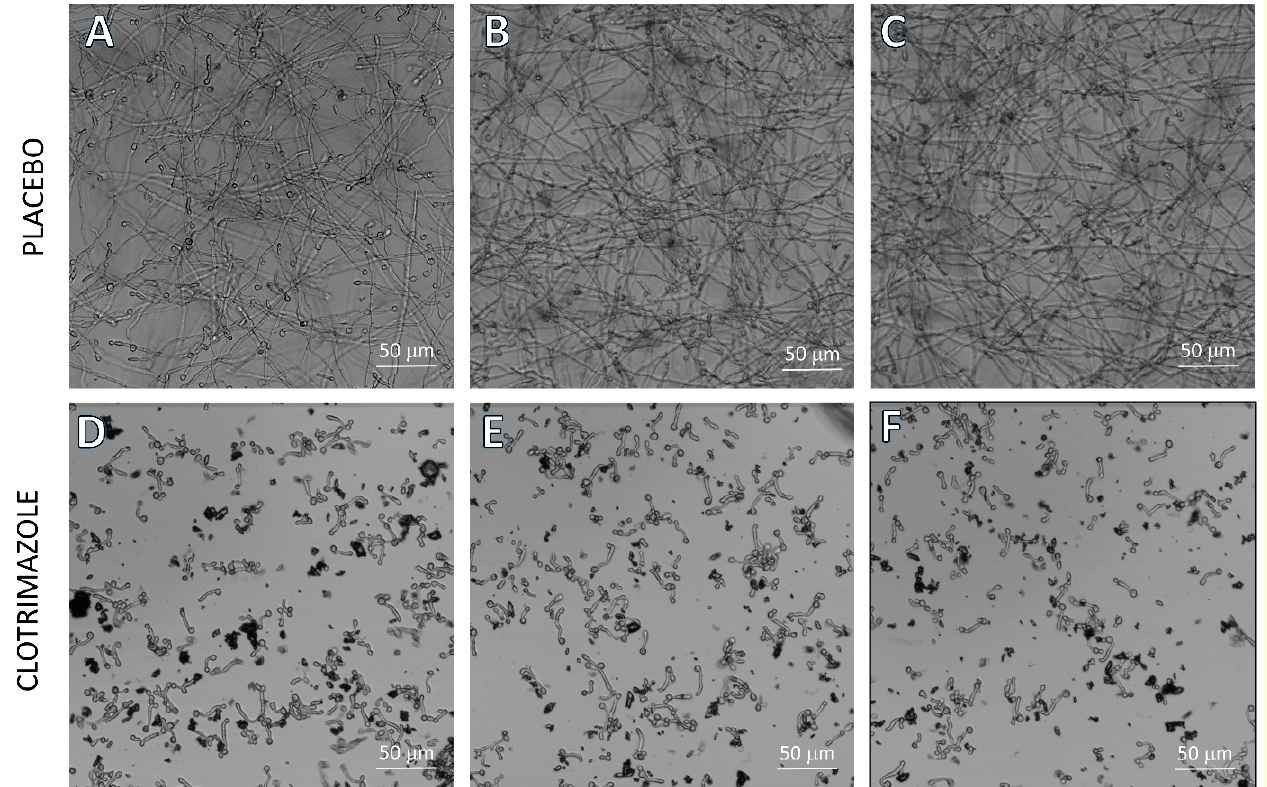
Figure 5. Microscope images of C. albicans exposed to SRV-CTZ- and placebo-coated VPs. SRV-CTZ- and placebo-coated VPs were daily exposed to fresh C. albicans cultures, and at day 36, images of three different samples were captured using a confocal microscope (Nikon Eclipse Ti-U). The fungi exposed to SRV-CTZ-coated VPs appear in yeast form with short hyphal outgrowth, in contrast to those exposed to SRV-placebo-coated VPs, which form networks of long hyphae.